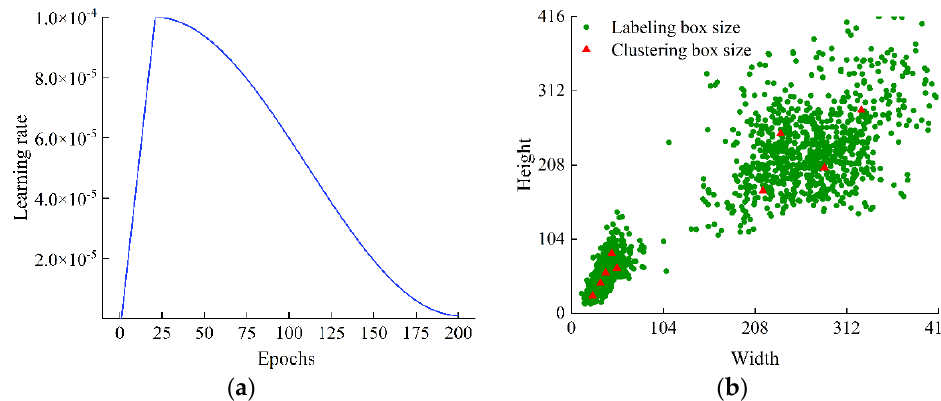
Figure 7. Schematic diagram of learning rate and labeling box. ( a ) Learning rate; ( b ) distribution of labelling boxes.